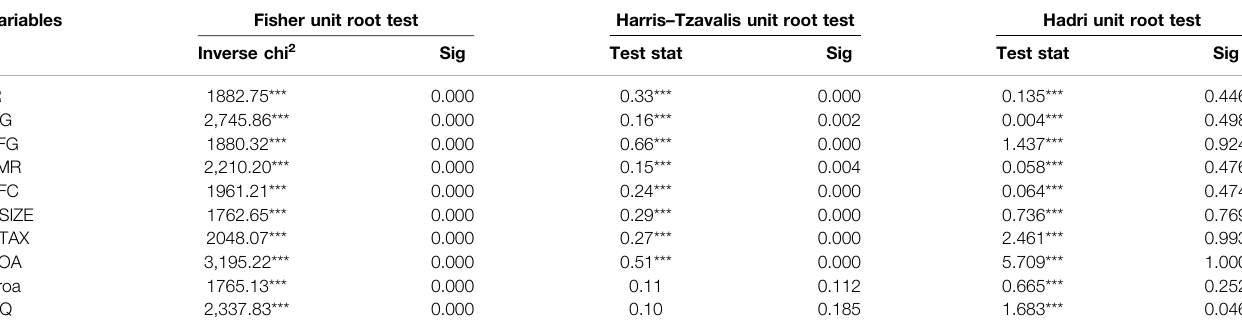
TABLE 4 | Data stationary tests.